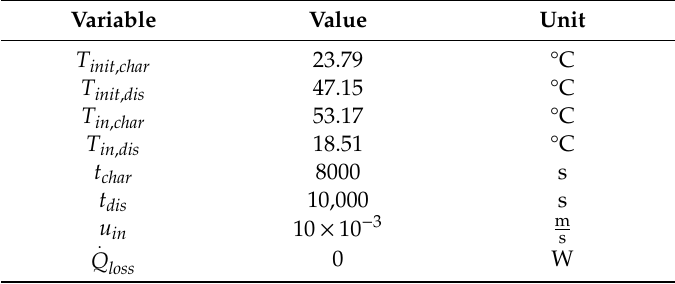
Table 3. Initial and boundary conditions for the reference